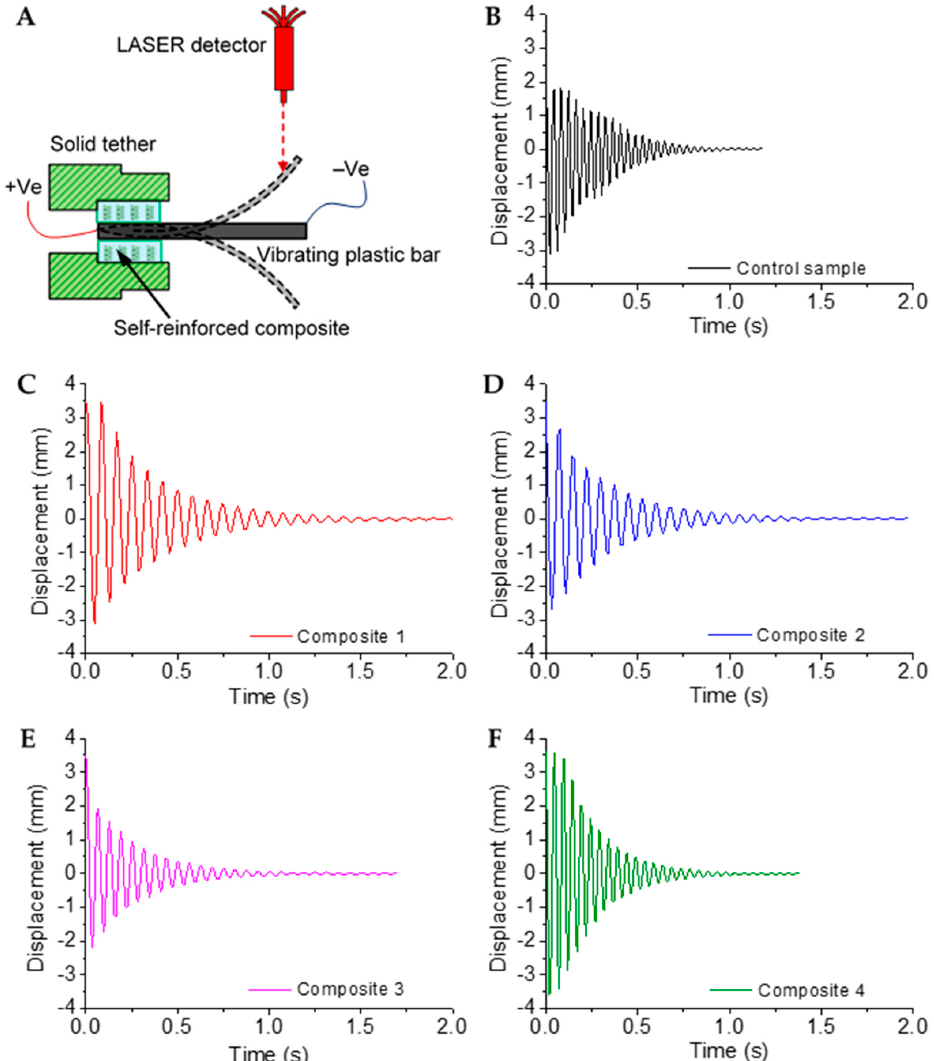
Figure 5. Vibration damping ability self-reinforced composites: ( A ) Schematic illustration of vibration damping measurements, ( B ) Control sample, ( C ) Composite 1, ( D ) Composite 2, ( E ) Composite 3, ( F ) Composite 4.